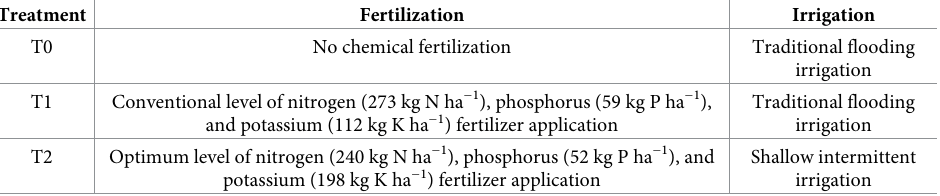
Table 1. The water and fertilizer practices used in this experiment.